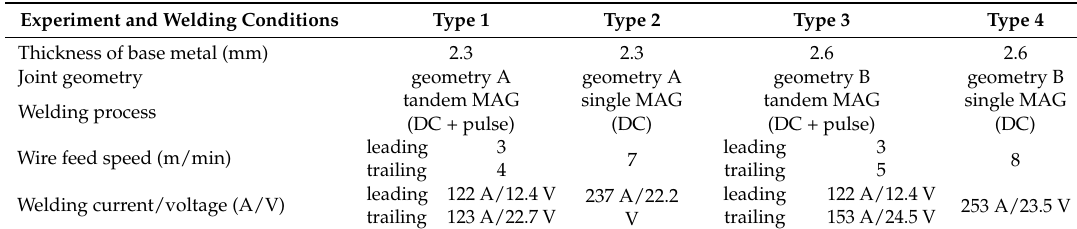
Table 3. Welding methods and conditions according to weld type (MAG: Metal active gas; DC: Direct